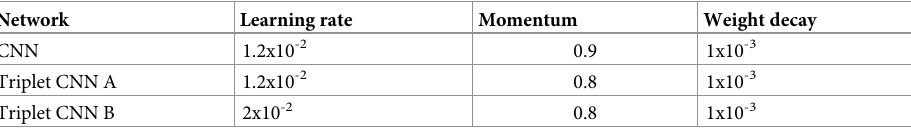
Table 6. Best hyper-parameters for training the networks in DeephESC